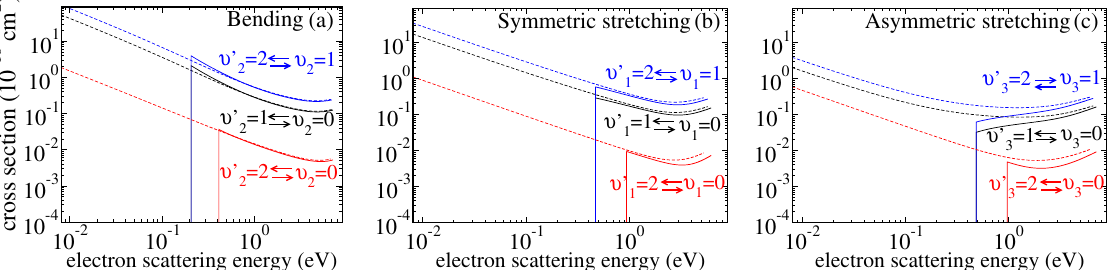
Figure 3. The calculated cross sections as functions of the electron scattering energy for the vibrational excitation of H 2 O for different vibrational states v i = 0,1,2 of the three normal modes i (see the text for detailed discussion): ( a ) cross − sections for the bending mode, ( b ) for symmetric stretching mode and ( c ) for asymmetric stretching mode.